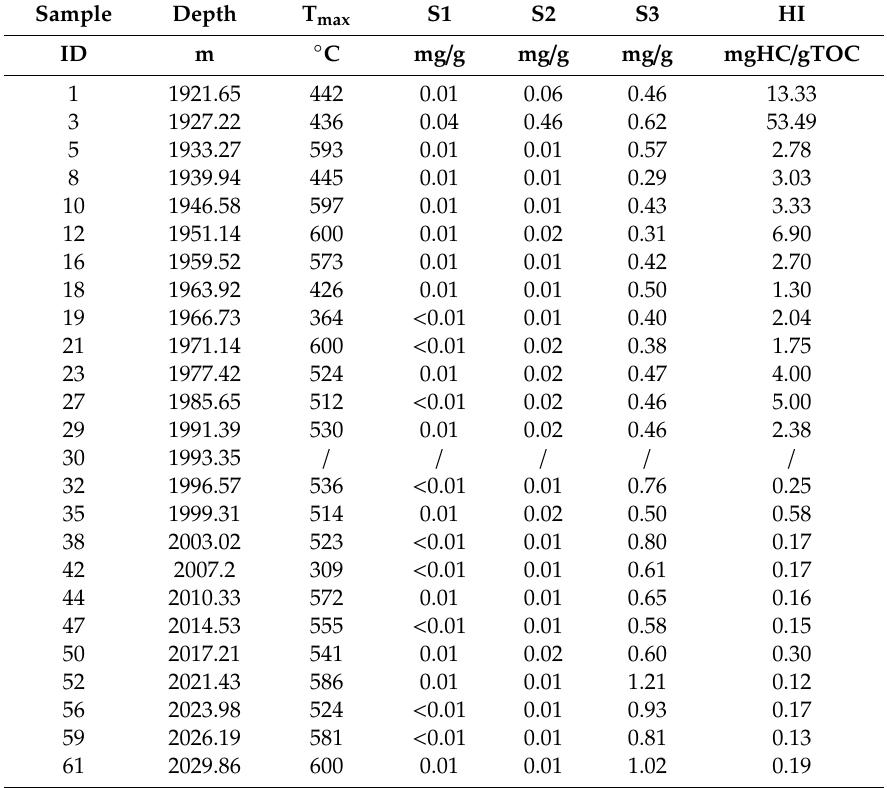
Table 4. Rock-Eval data and HI of samples.